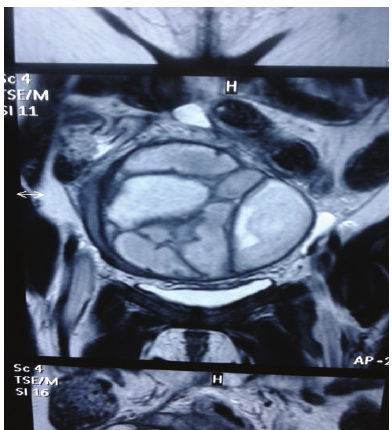
Figure 1: MRI of pelvis showing bilateral tuboovarian masses.